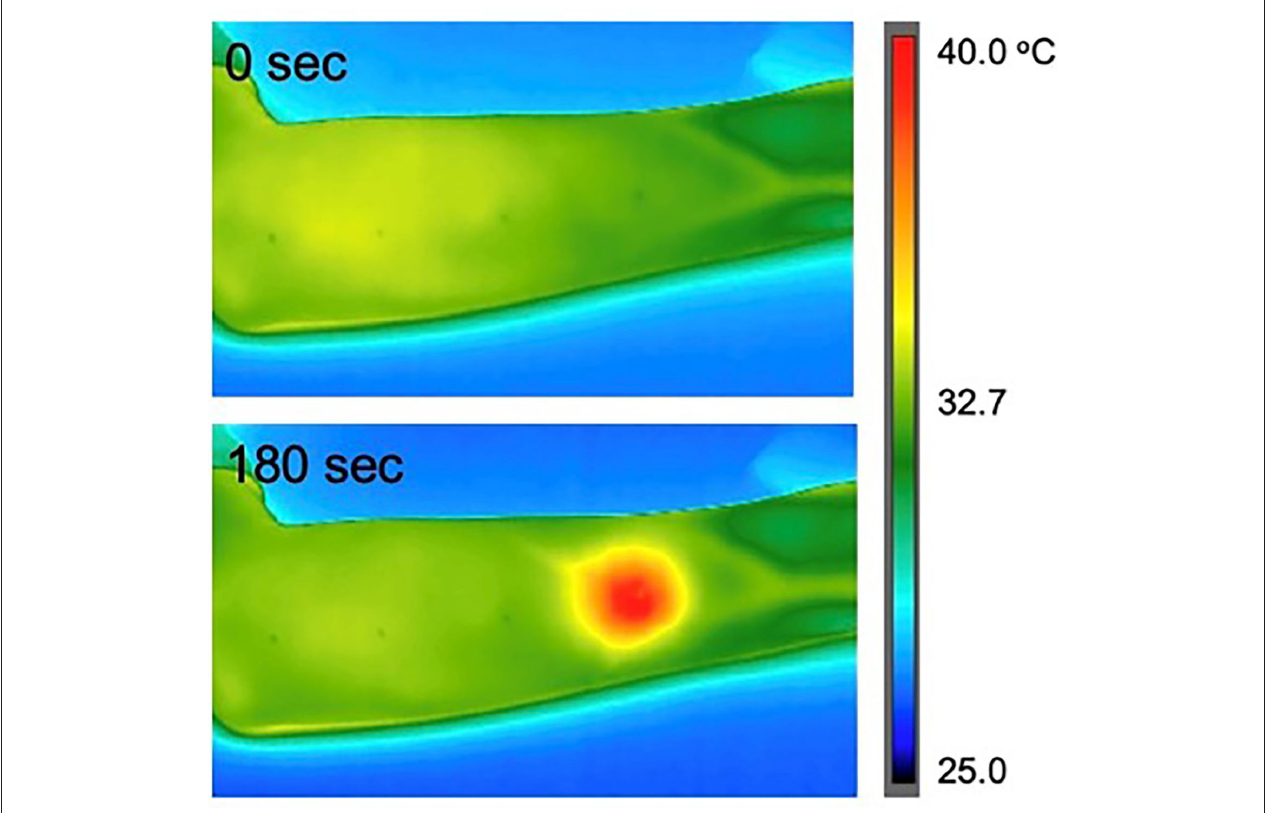
FIGURE 9 | Temperature elevation in the human forearm skin during the exposure to 60 GHz MMW at 2W of total antenna input